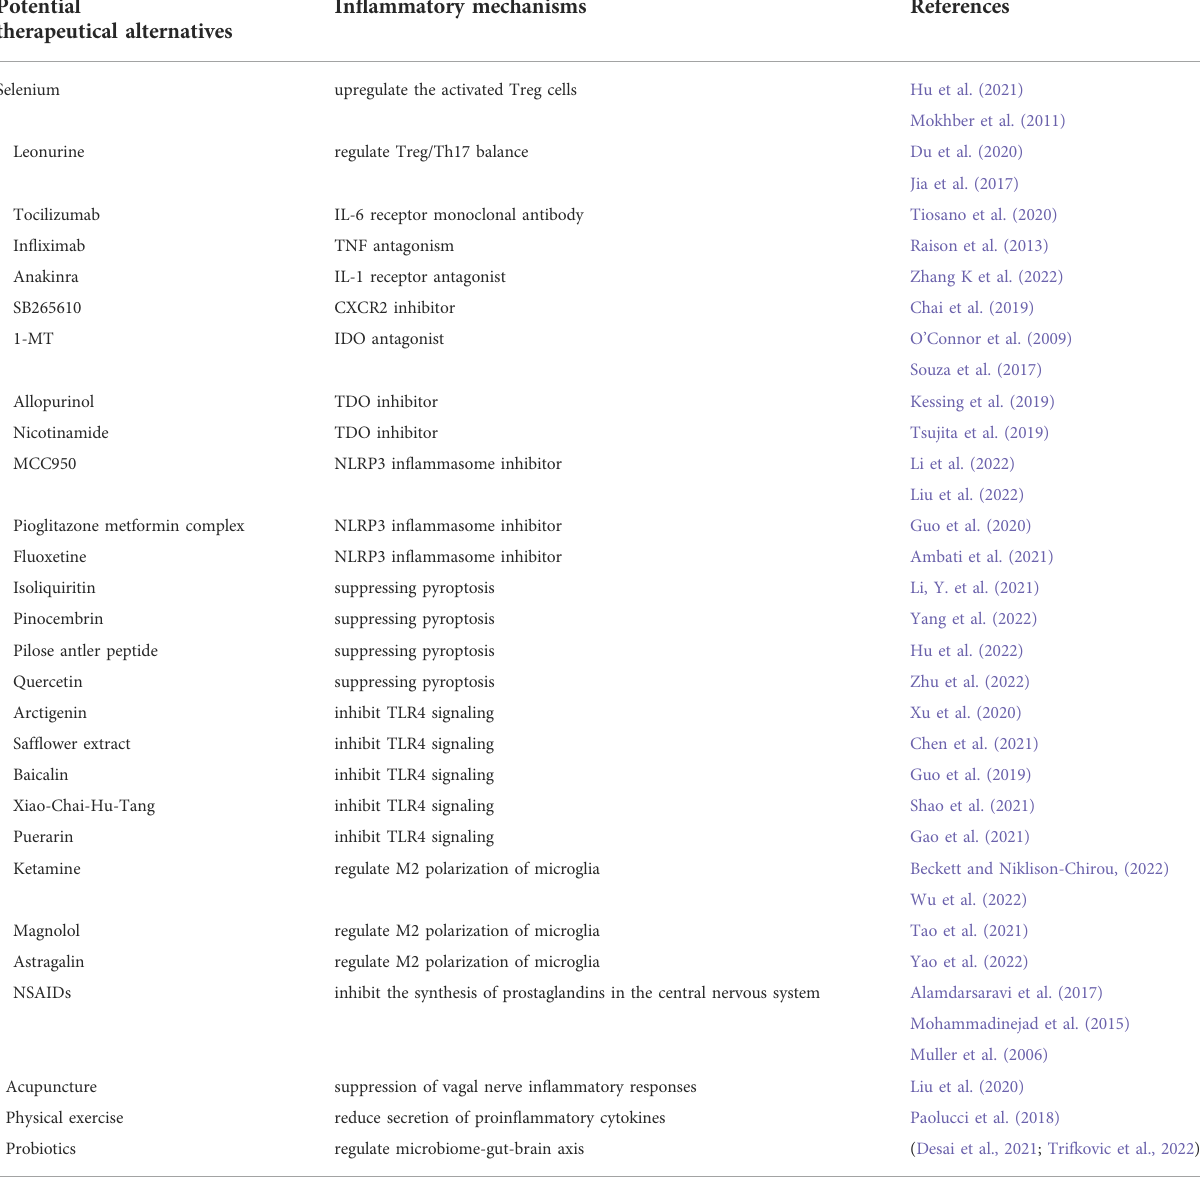
TABLE 2 The summary of potential therapeutical alternatives targeting the in fl ammatory mechanisms for postpartum